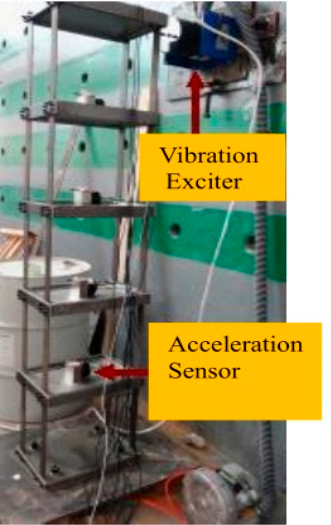
Figure 13. The five ‐ story steel frame.